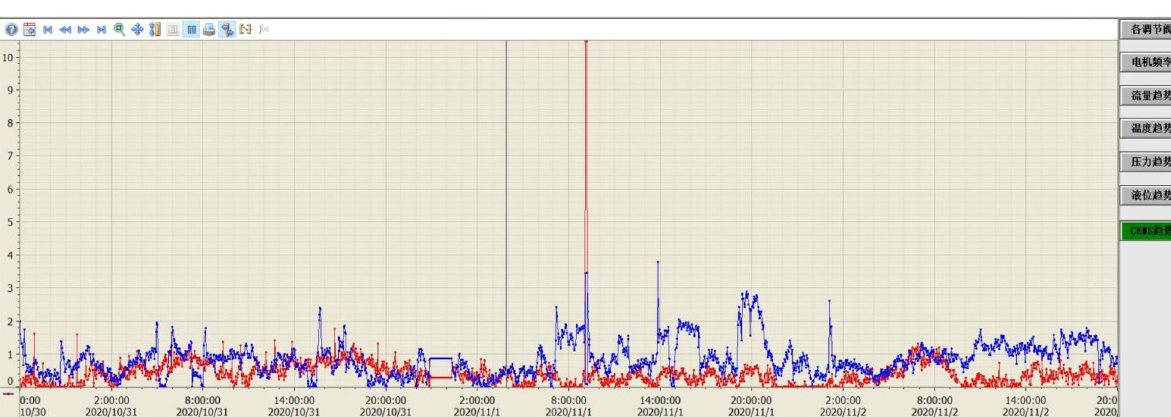
Figure 17. SO 2 (red) and NO x (blue) concentration of outlet flue gas during 72-h